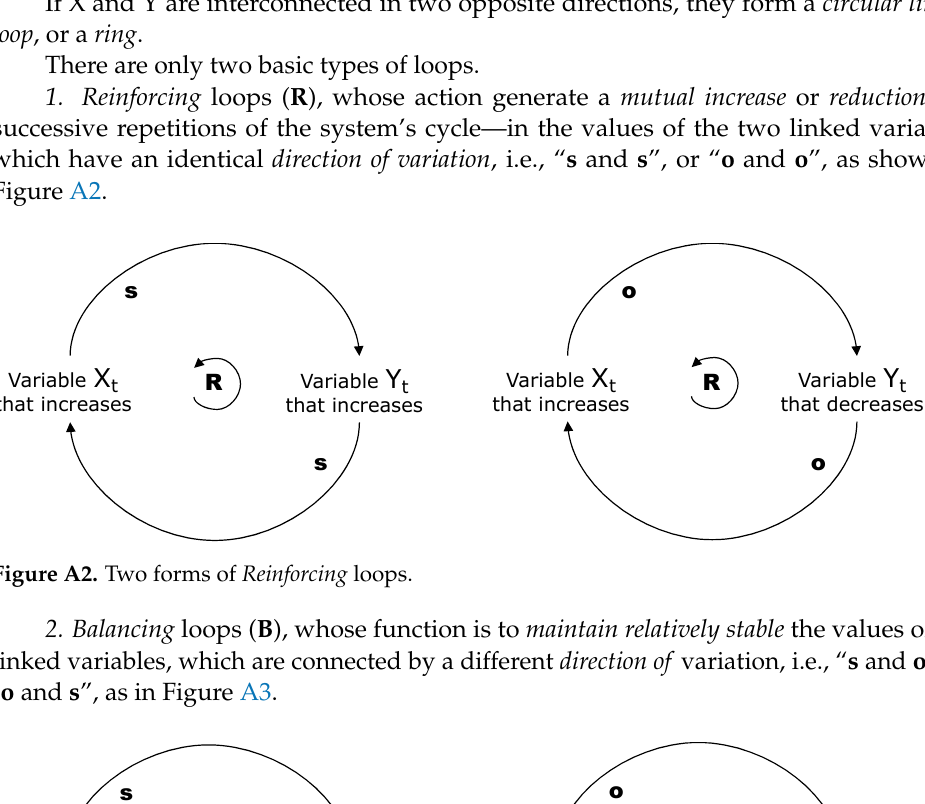
os Variabile X t B Variabile Y t that increases that stabilizes